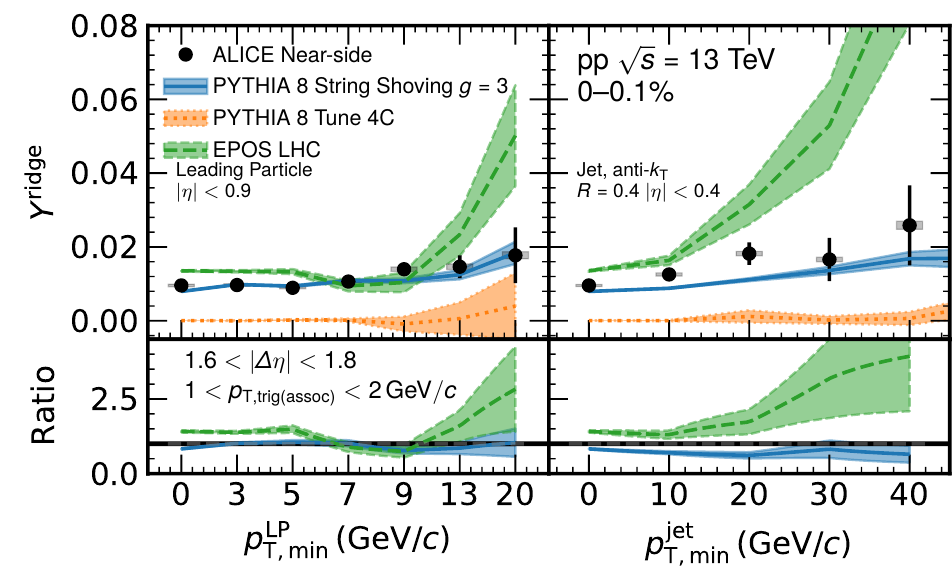
Figure 6 . Near-side ridge yield as a function of the p LP (left) and p Jet (right). Data points T , min T , min (filled circles) show the ALICE measurement. The statistical and systematic uncertainties are shown as vertical bars and boxes, respectively. As the ridge yield is obtained in the same operational way for data and models, the upper limit of the systematic uncertainty due to jet contamination, which is 18.9%, is not included in the figure. The data are compared with predictions of models which are represented by colored bands. The bottom panel shows a ratio of the models to the data. The uncertainty of the data is represented by the gray band centered around